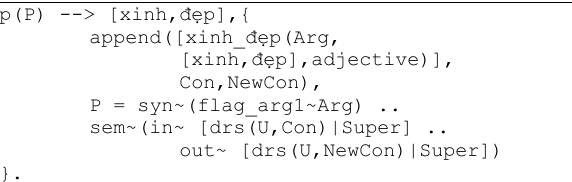
Figure 10. Describe adjective “xinh đẹp” (example 5) based on framework GULP